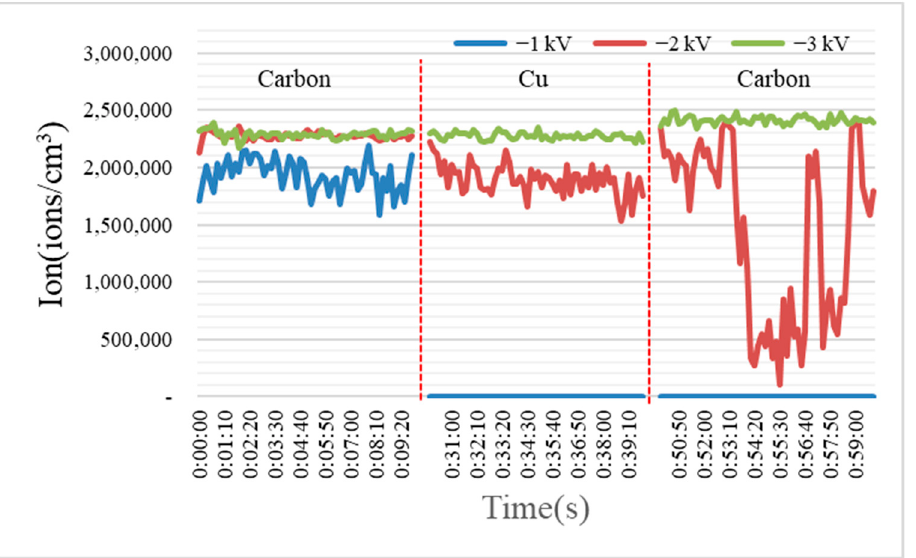
Figure 2. Ions generated by material and voltage. Table 1. Average ion amount generated by material and